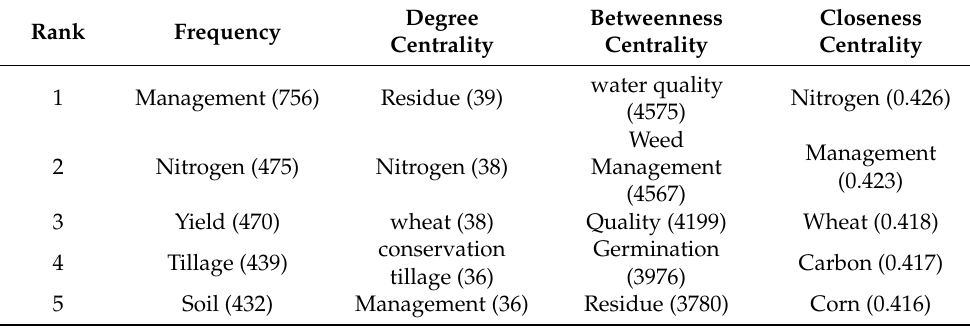
Table 6. Top five subject terms in co-occurrence network by four